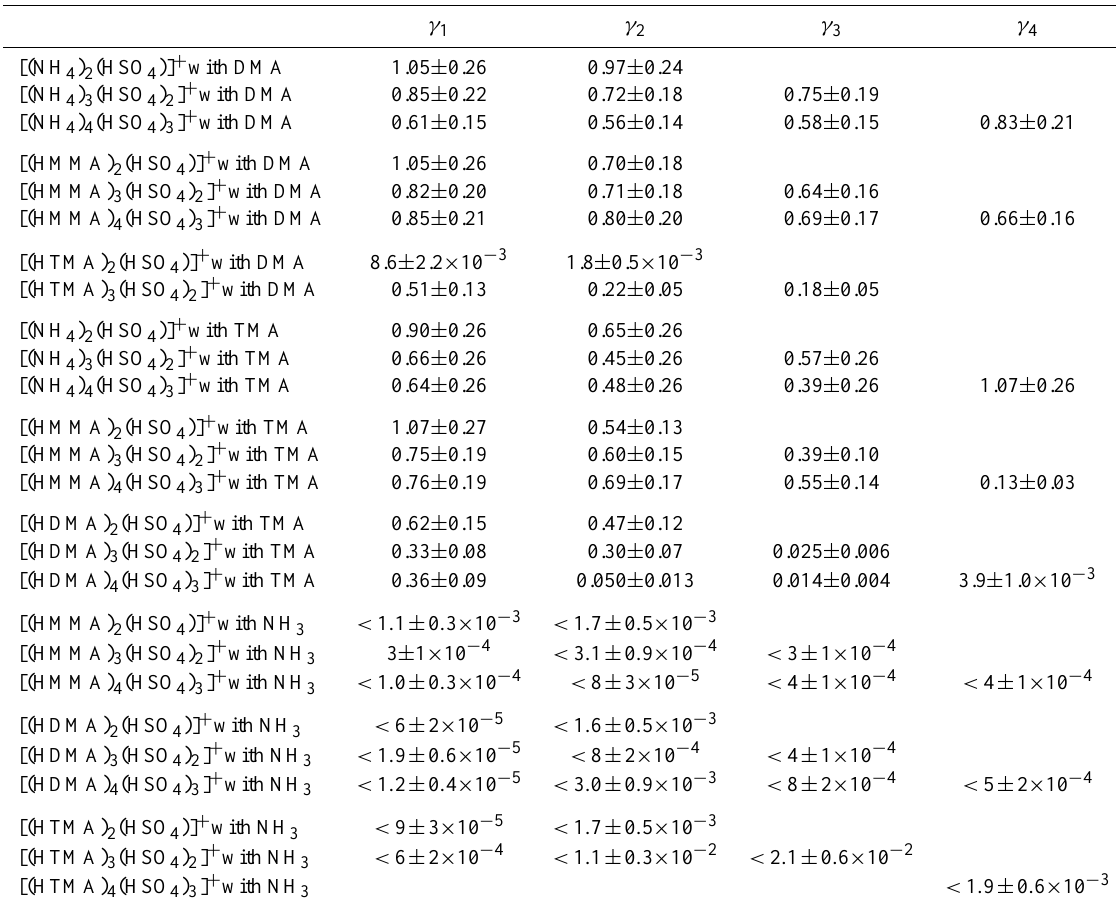
Table 3. Uptake coefficients for the substitution reactions of bisulfate clusters.